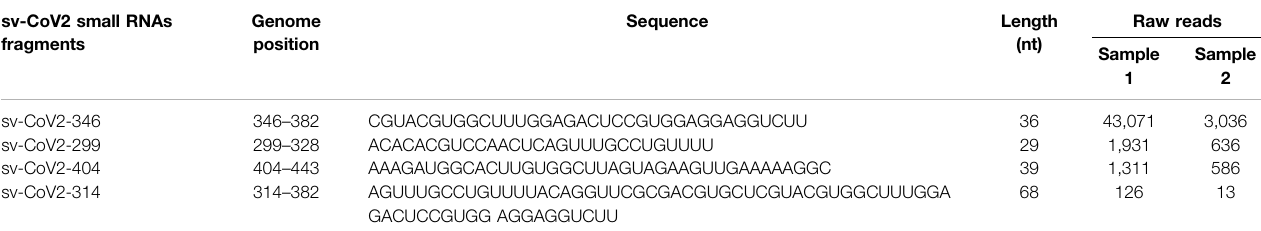
Sequence Length